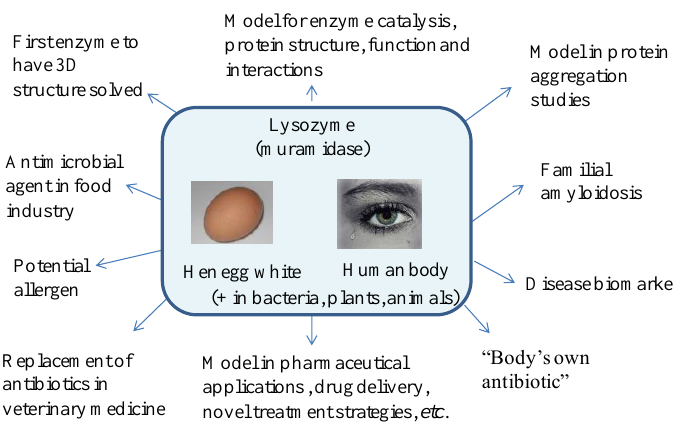
Figure 1. The relevance of lysozyme for protein science, medicine and industrial applications.